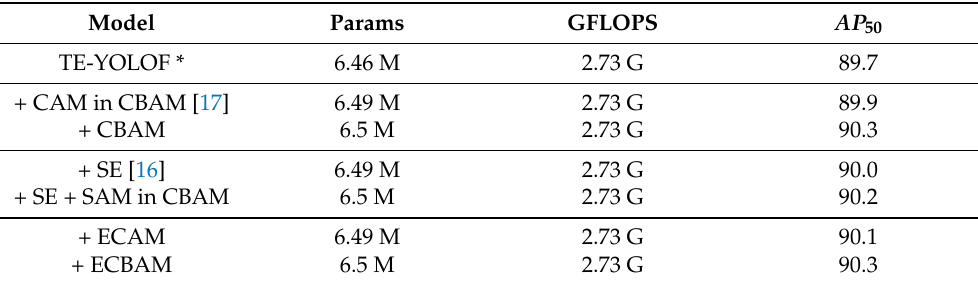
Table 3. Add Spatial Attention Module or not. ‘TE-YOLOF *’ represents the same setting in TE- YOLOF-B0 used in Table 2. Each grid above is used to compare adding a spatial attention module or not in different channel attention mechanisms.